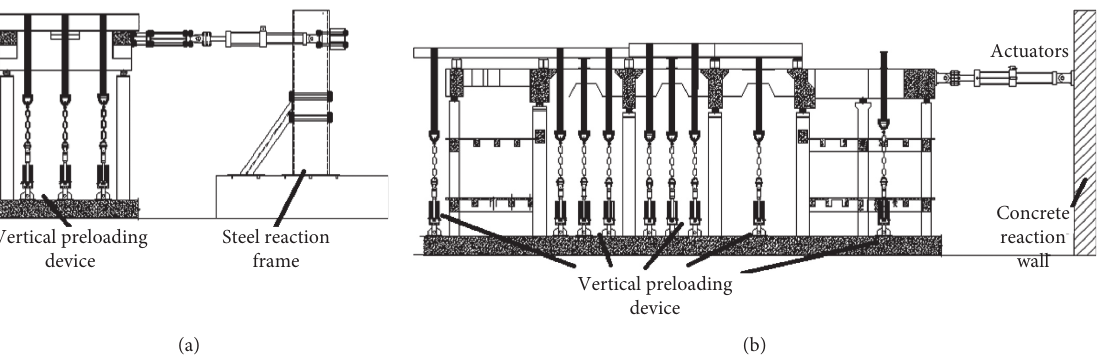
Figure 6: Loading system for pseudodynamic experiment. (a) Transverse loading. (b) Longitudinal loading.